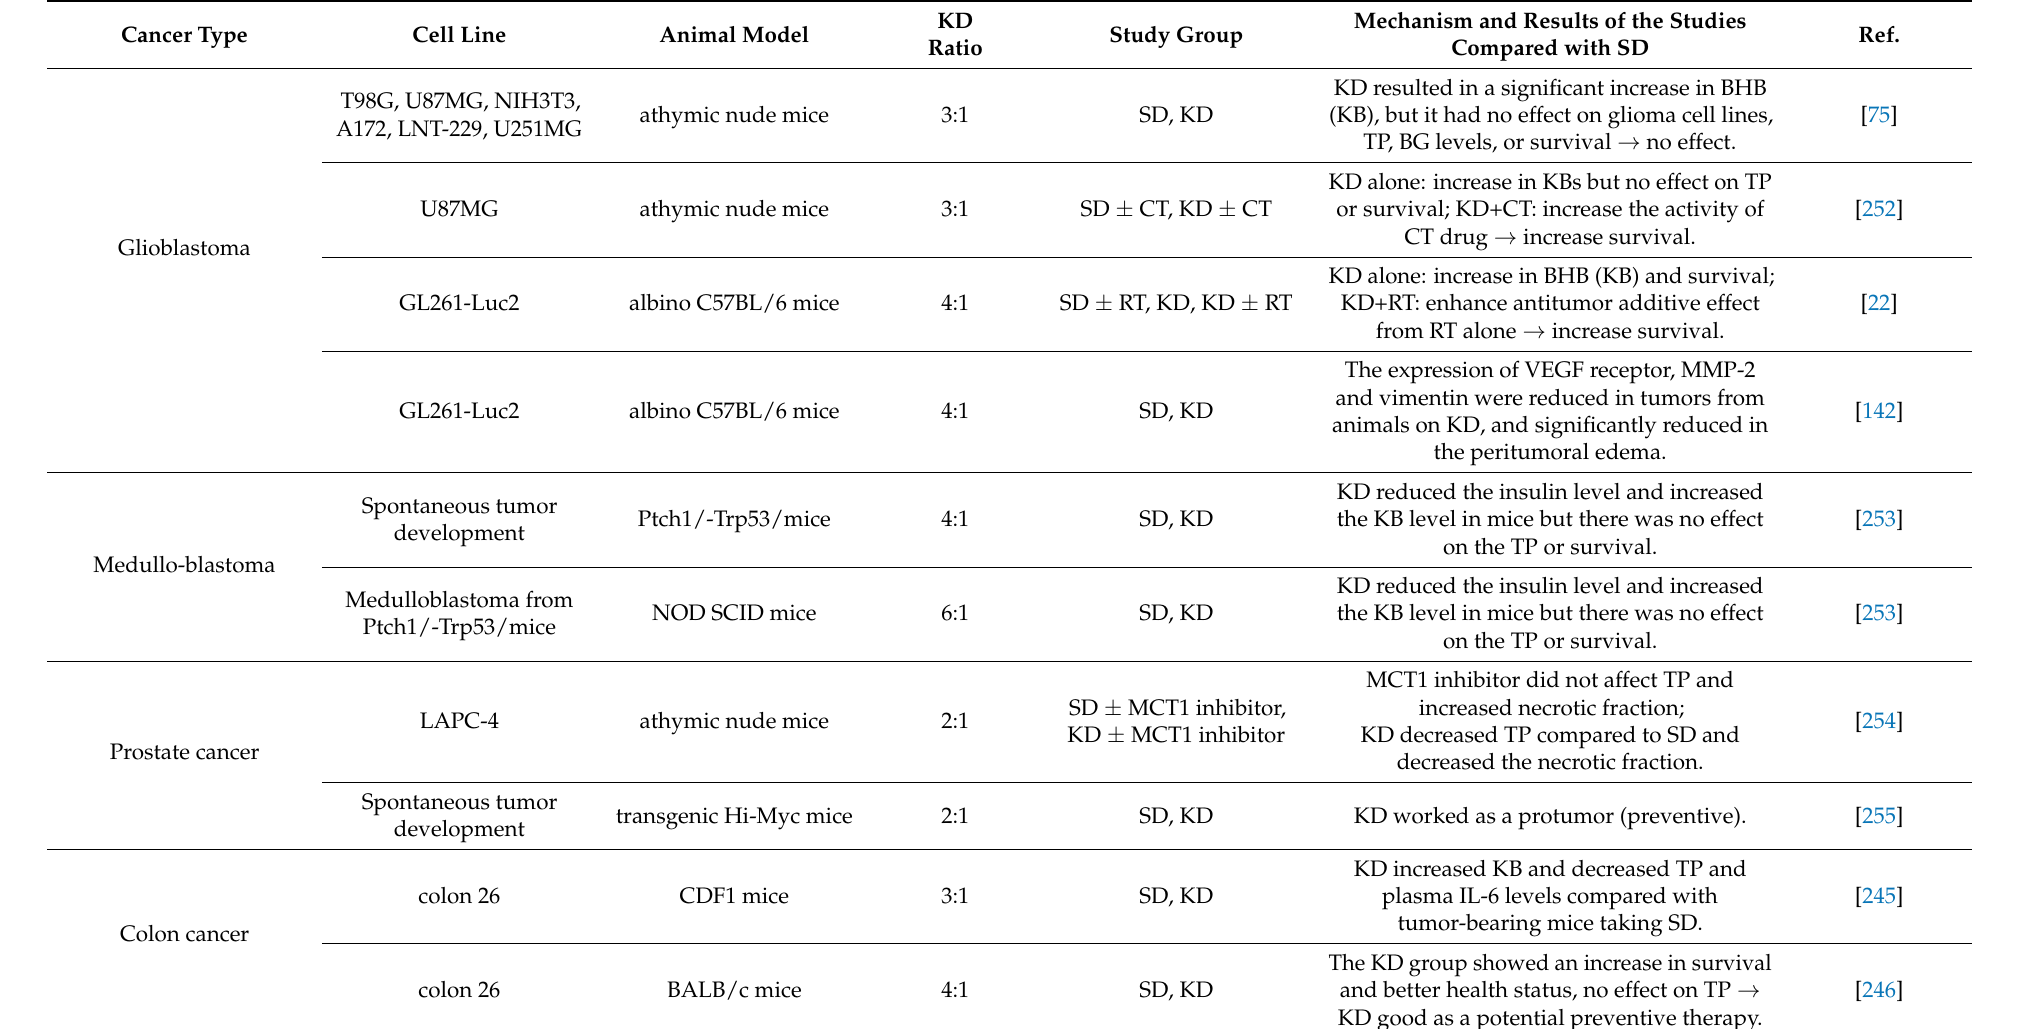
Table 1. Some of the preclinical studies for the effect of ketogenic diet on cancer (tumor)